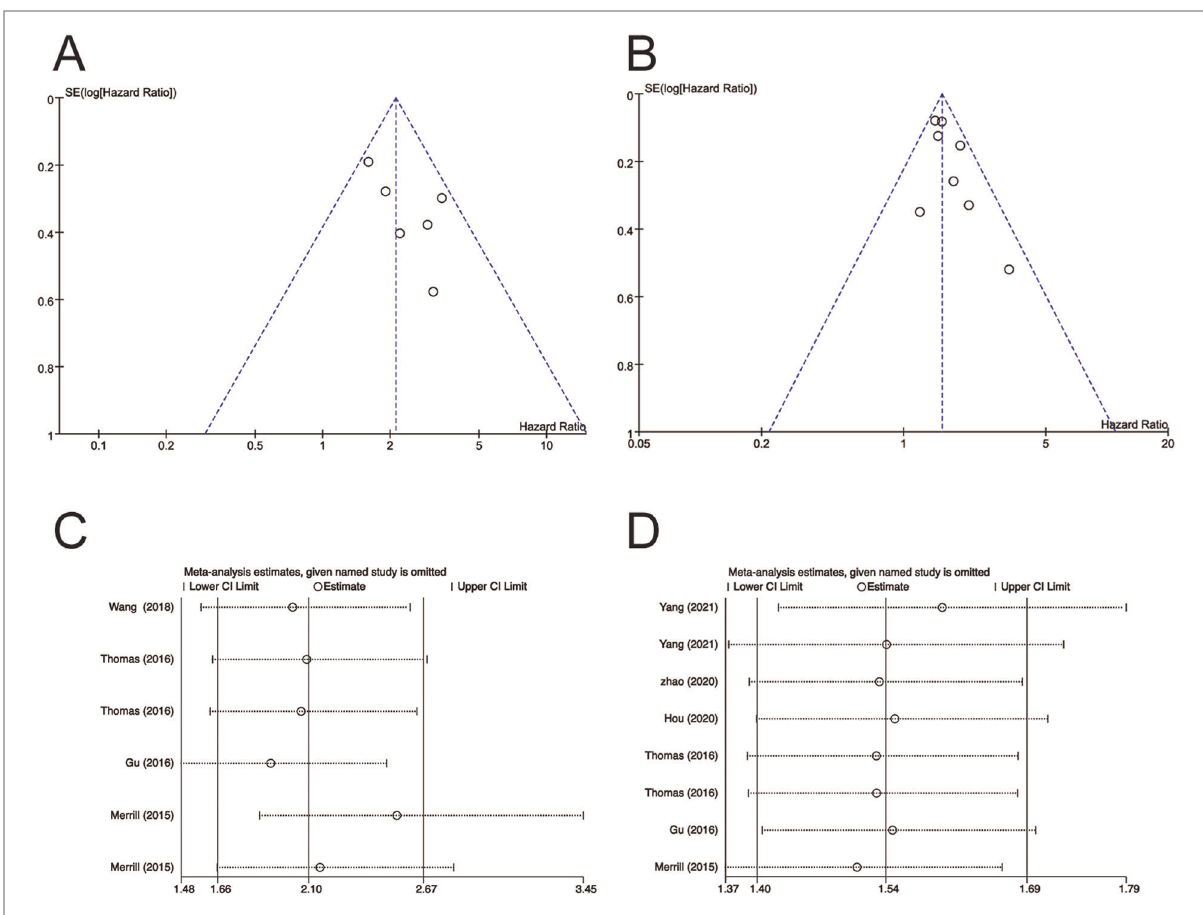
FIGURE 5 Funnel plot for ( A ) T stage (3 – 4 vs 1 – 2) of OS; ( B ) positive lymph node of OS. Sensitivity analysis for ( C ) T stage (3 – 4 vs 1 – 2) of OS; ( D ) positive lymph node of OS. OS, overall